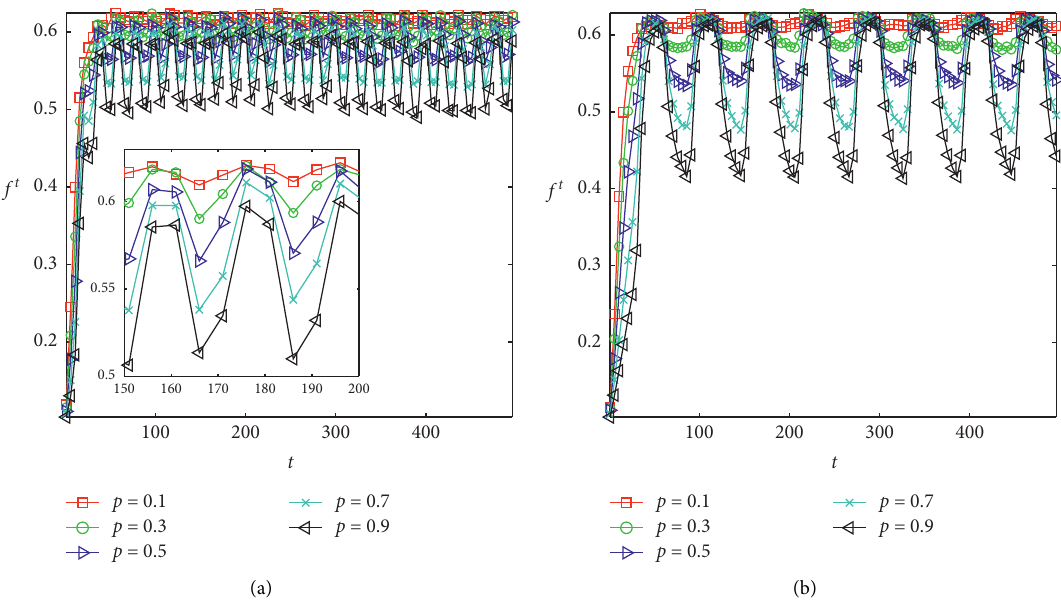
Figure 6: The evolution of the infected density f t with time under different value of p . We find the fluctuation range of the infected density increase with p and t s . The parameters are set as follows: α � 0 . 5, β � 0 . 1, λ